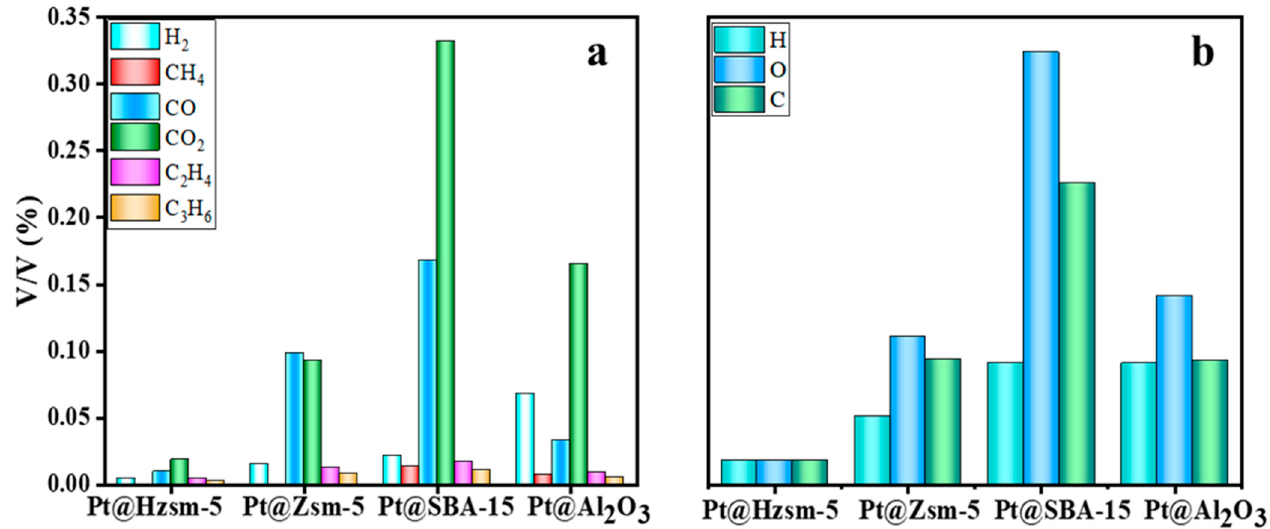
Figure 6. Gas analysis of Pt-based catalysts with different carriers: ( a ) distribution of the gas product components; ( b ) migration of the carbon, hydrogen, and oxygen elements in gases.